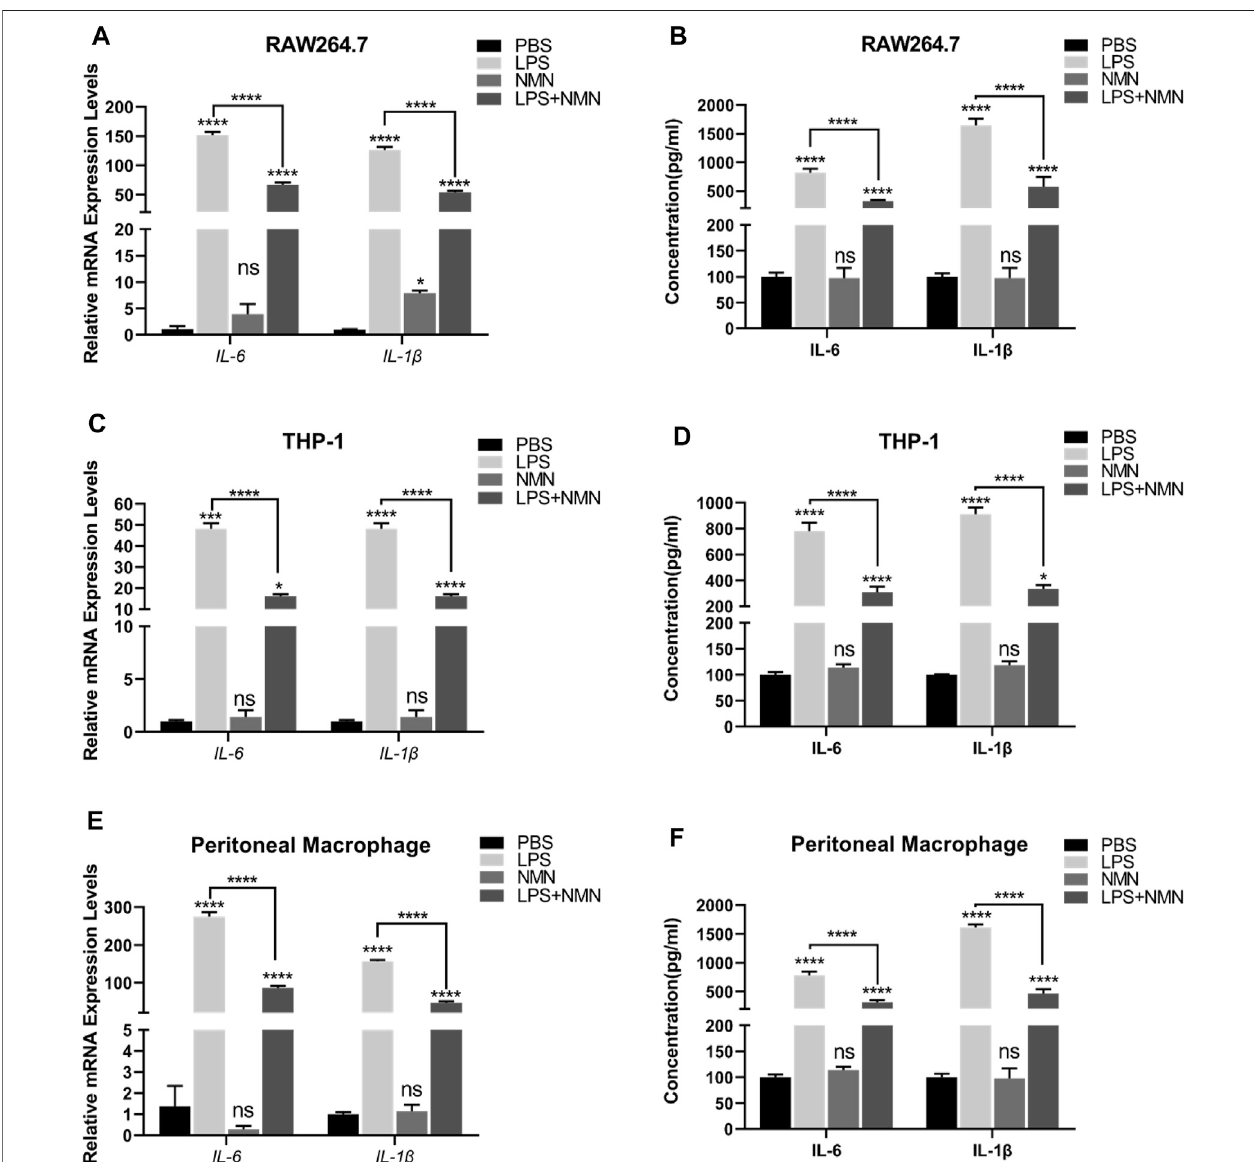
FIGURE 3 | NMN suppressed in fl ammatory cytokines in LPS-induced macrophages (A,C,E) The mRNA expressions of IL-6 and IL-1 β were examined by RT- qPCRinuntreated,LPS-treated,NMN-treated,LPS/NMNco-treatedRAW264.7cells,THP-1cellsandmouseperitonealmacrophages. (B,D,F) TheELISAresultsofIL- 6andIL-1 β inuntreated,LPS(100 ng/ml)-treated,NMN(500 µM)-treatedandLPS-NMN-treatedRAW264.7cells,THP-1cellsandmouseperitonealmacrophages.The experiment was performed in triplicates and repeated three times. P values were calculated using one way ANOVA test. **** p < 0.0001, ** p < 0.01, * p < 0.05; mean ±